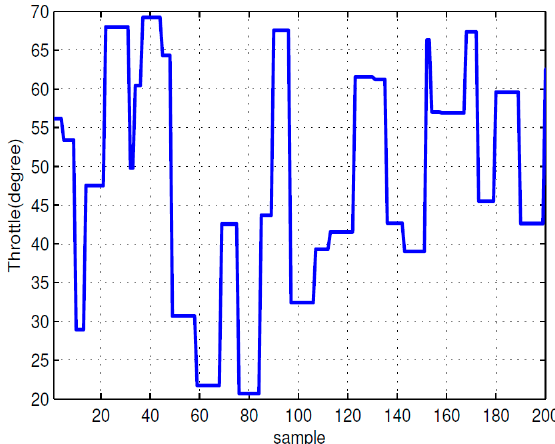
Figure 3. RAS for the throttle angle.